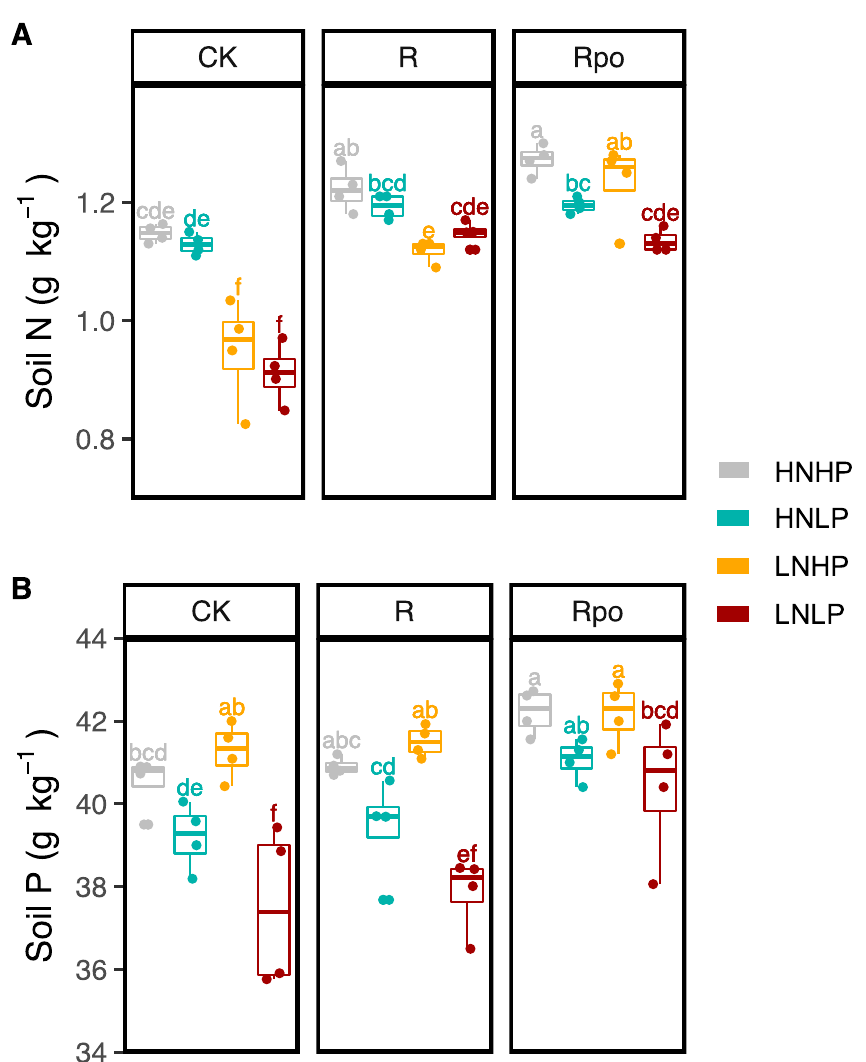
Figure 5. Contents of nitrogen ( A ) and phosphorous ( B ) in soil of soybean plantings after exclusive Rhizobium inoculation and Rhizobium inoculation combined with biochar application under high or low N and P supply. Letters within each column are significantly different at p < 0.05 based on Duncan’s test.